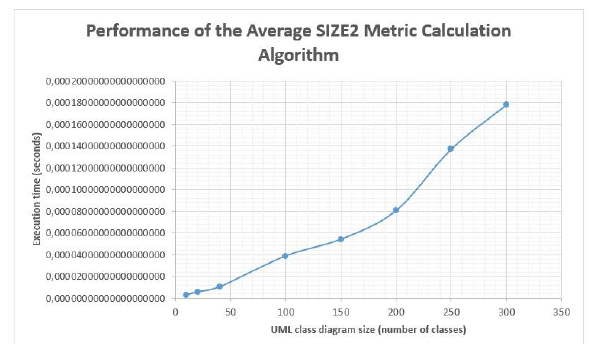
Fig. 12. Performance of the DSC Metric Calculation Algorithm